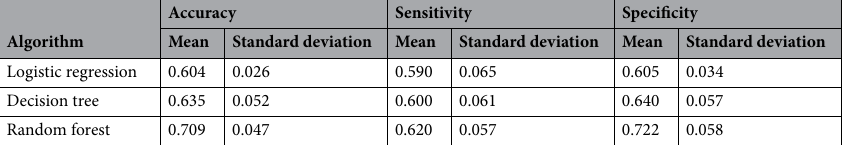
Table 5. Comparison of the performance in RUTI prediction models after hospitalization for UTI through fivefold cross validation (sample size = 809). Abbreviations: UTI, urinary tract infection; RUTI, recurrent urinary tract infection.